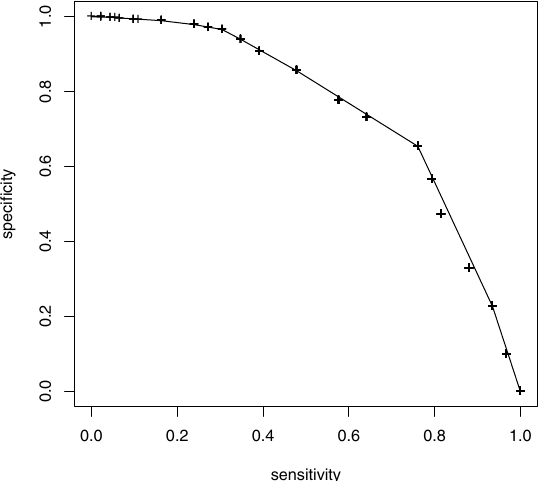
Figure 1. ROC curve (convex hull) for prediction of postpartum EPDS score ≥ 10 from antenatal EPDS scores (AROC 0.756) at various cut-offs